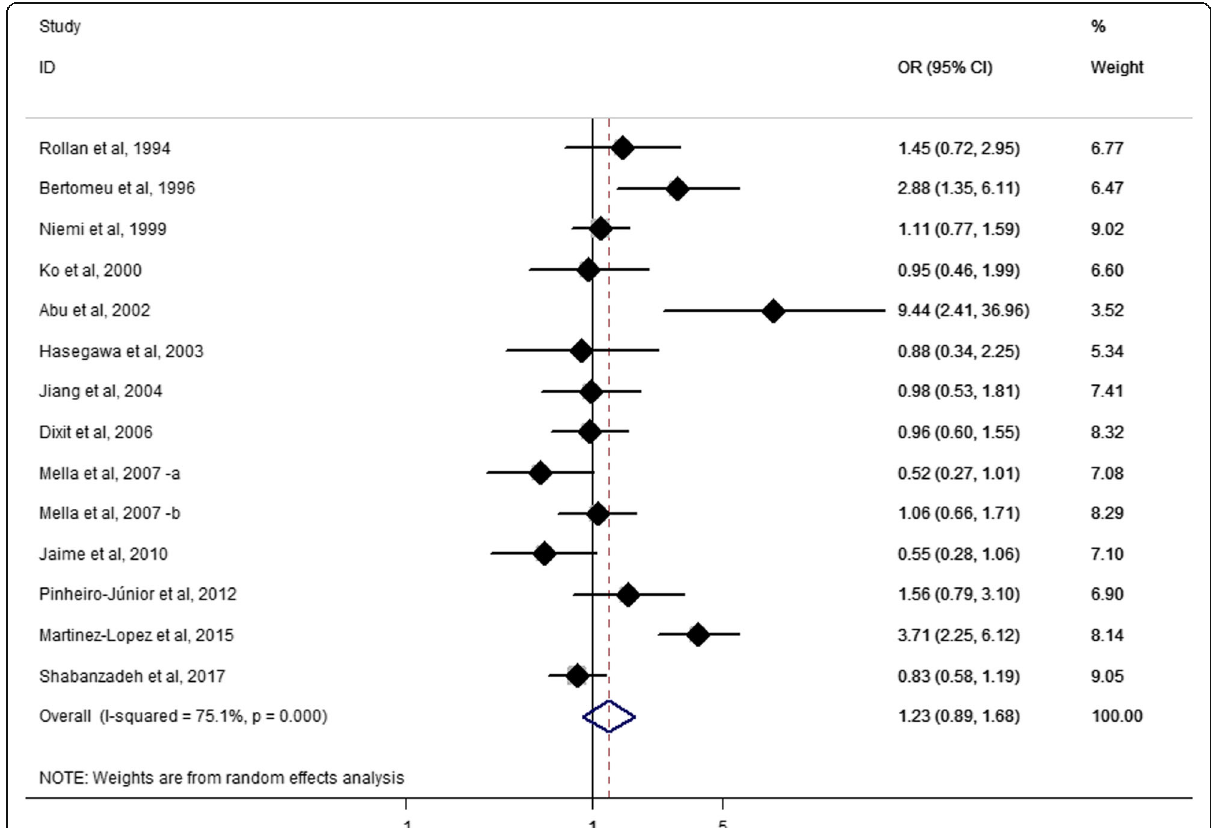
Fig. 3 Forest plot for meta-analysis of the association of APOE E4 with GSD risk. Each study is represented by a square whose area is proportional to the weight of the study. The overall effect from meta-analysis is represented by a diamond whose width represents the 95% CI for the estimated odds ratio (OR). GSD, gallstone disease; OR, odds ratio; CI, confidence